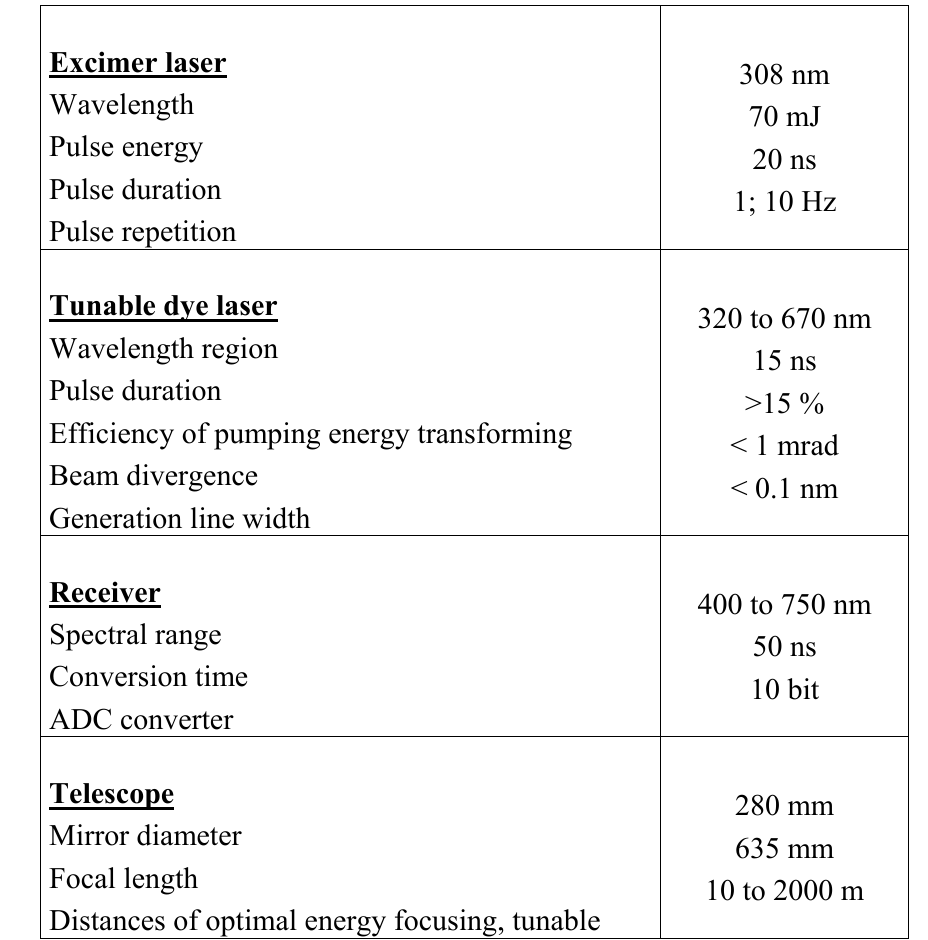
Table 4. Technical parameters of the lidar system